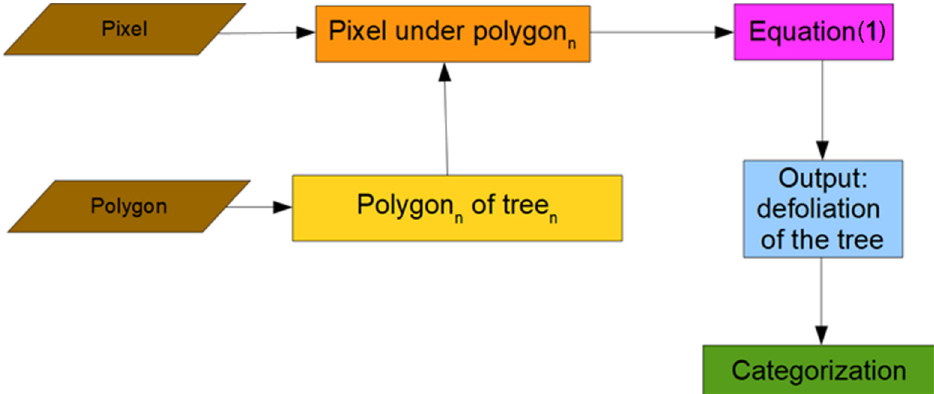
Figure 6. Workflow of the model for tree damage classification.